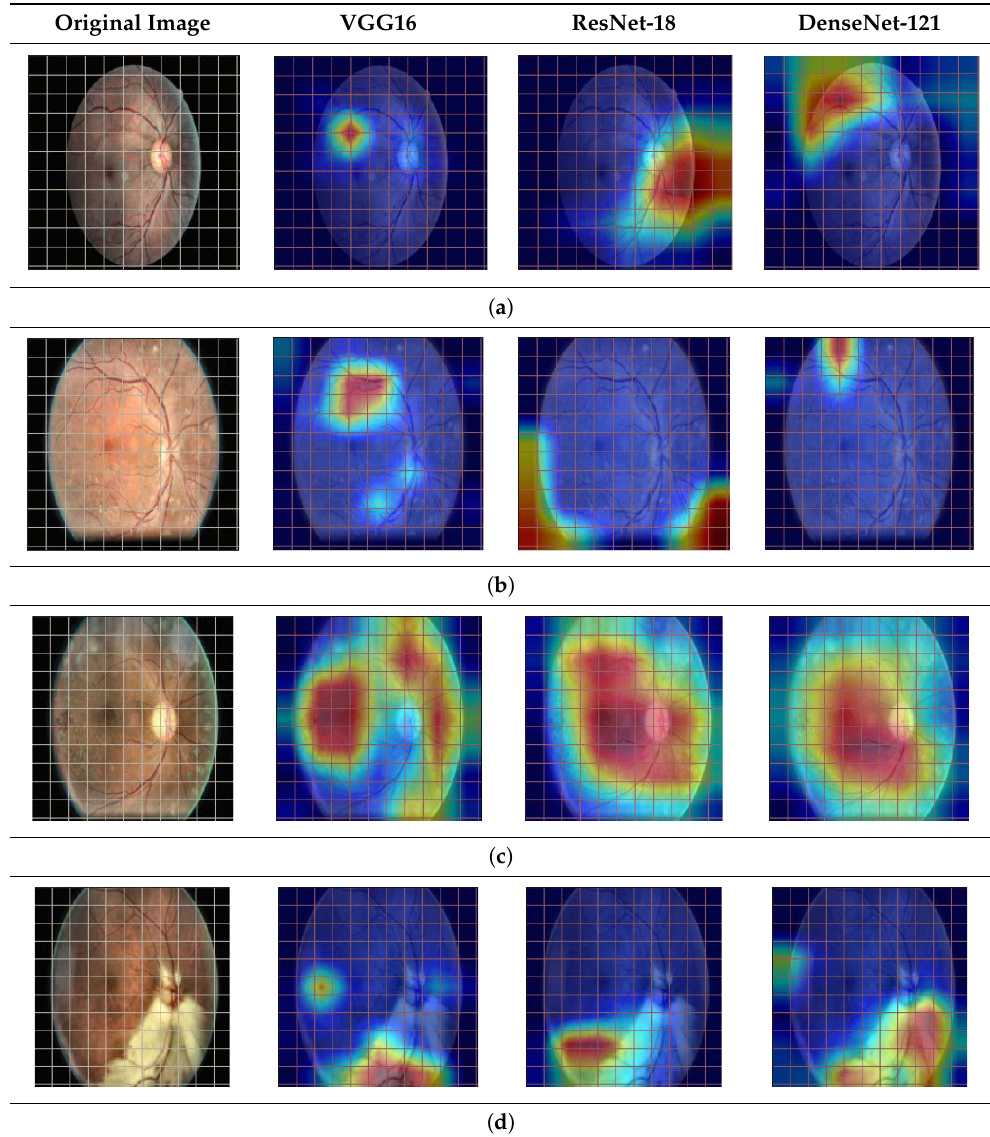
Table 4. Examples of Grad-CAM output of the evaluated deep learning models.